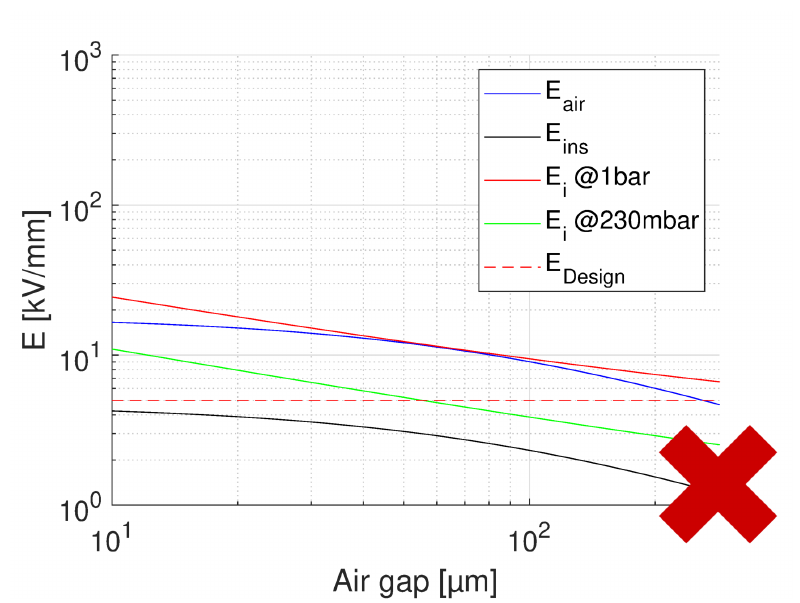
Figure 15. Feasibility plot for the optimum design of phase-to-phase insulation, with the highest design field (5 kV/mm) and thinnest insulation (H3 = 285 µ m). Nominal operating voltage = 1333 V (Table 1). The x axis reports the air gap thickness. No PD will be incepted in cavities of any size at ground pressure, but PD will likely incept for cavities at 35,000